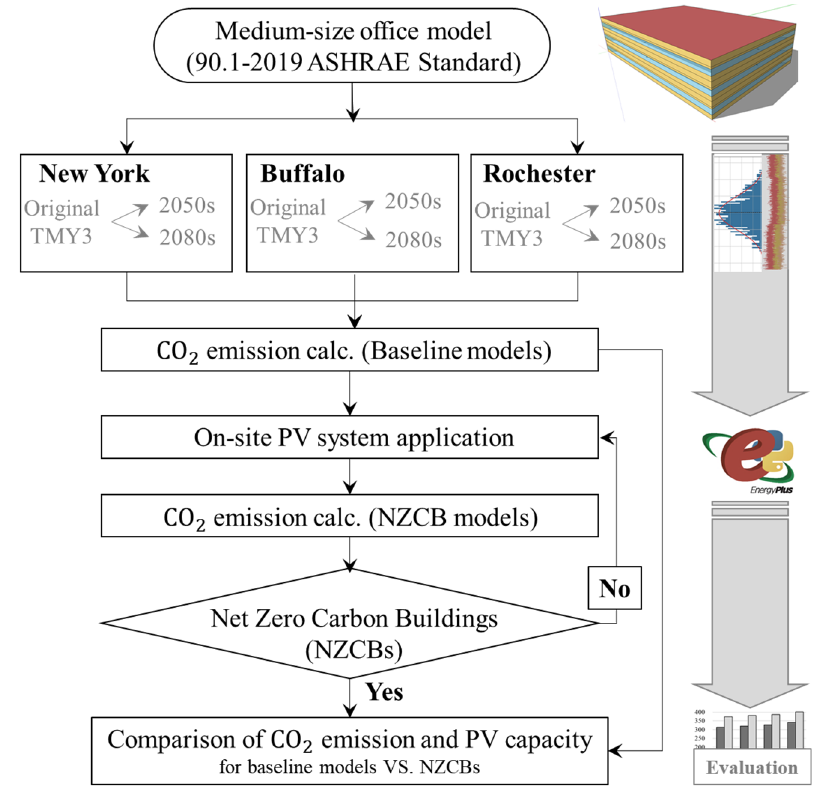
Figure 8. Flowchart of a simulation procedure.